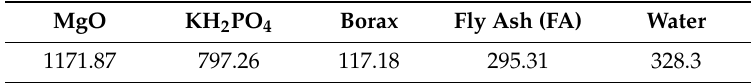
Table 2. Mix proportion of magnesium phosphate cement (MPC) (kg / m 3 ).